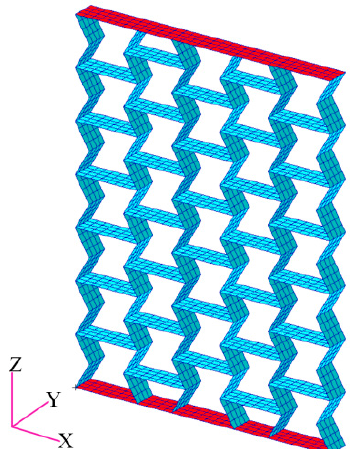
Figure 8. The FE model for the dynamic analysis of the auxetic honeycombs.